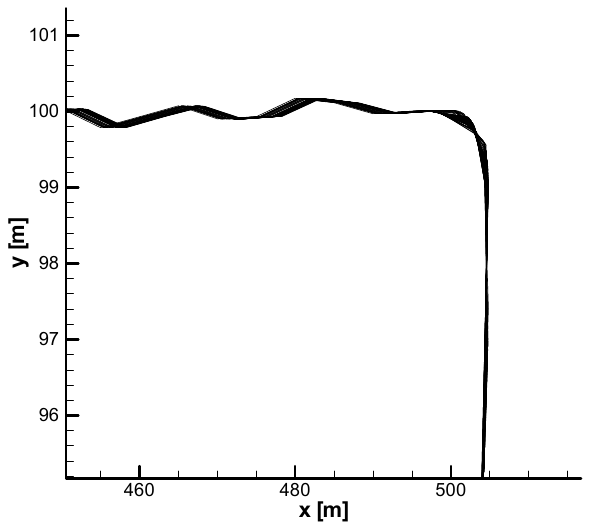
Figure 33. Trajectory beam in lateral view, case 2—detail A.